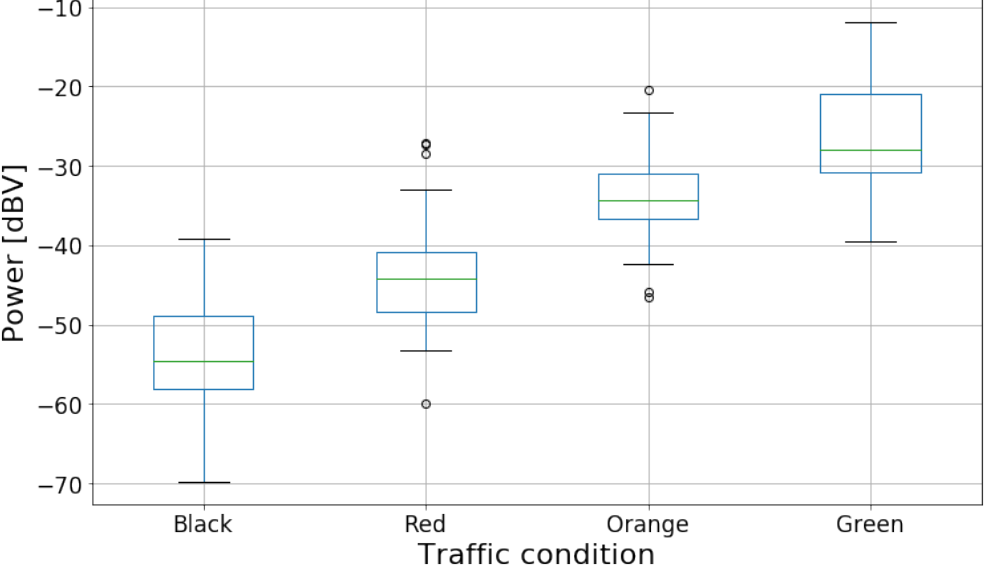
Figure 5. Box plot of noise power data divided by traffic